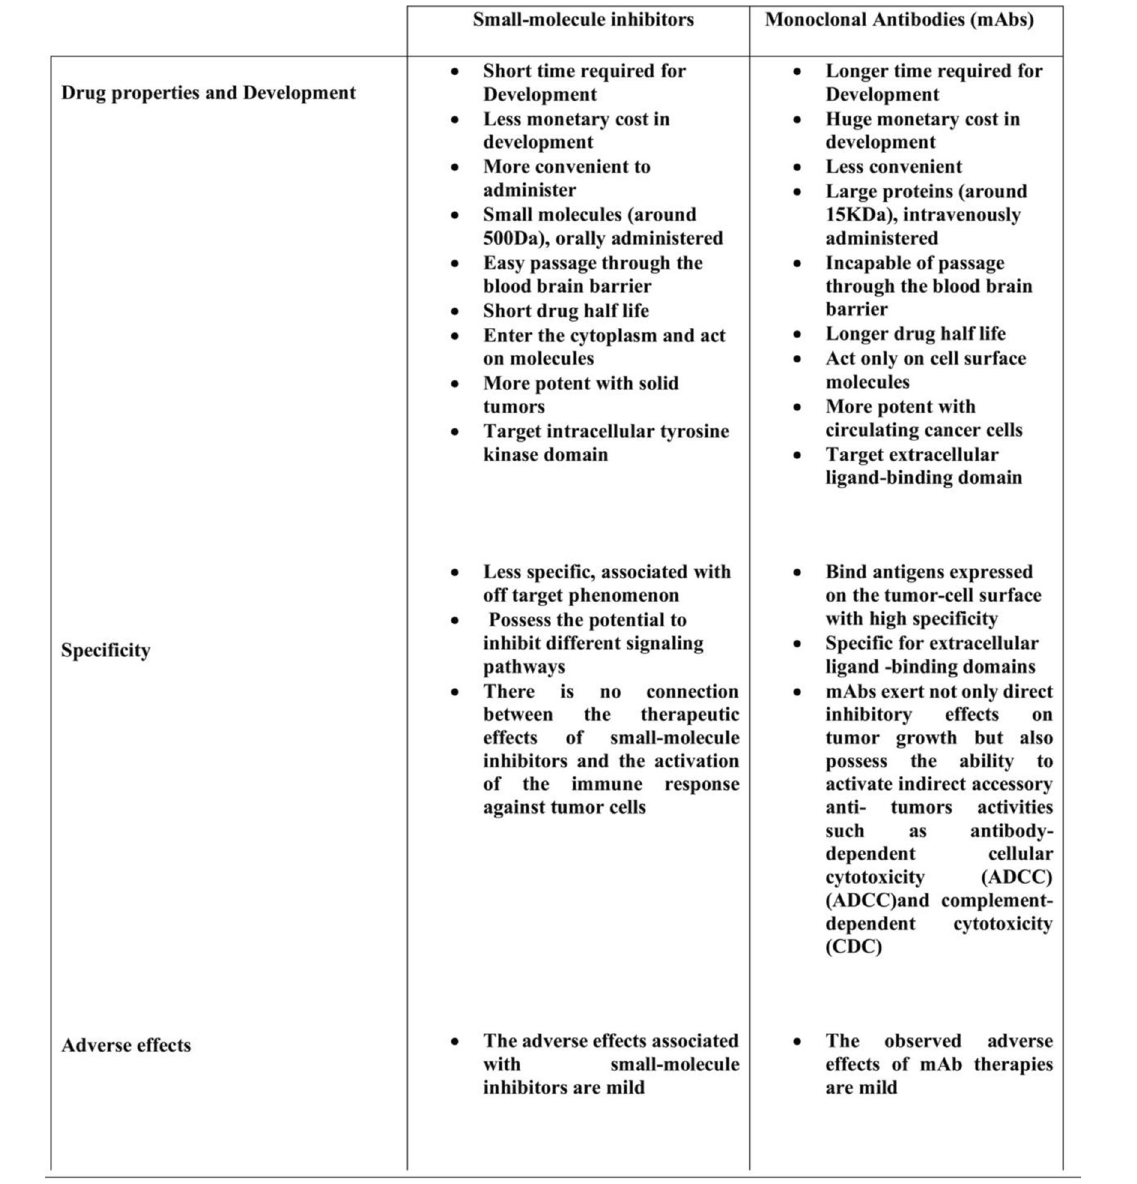
Table 1 Comparison of Small-molecule Inhibitors and Monoclonal